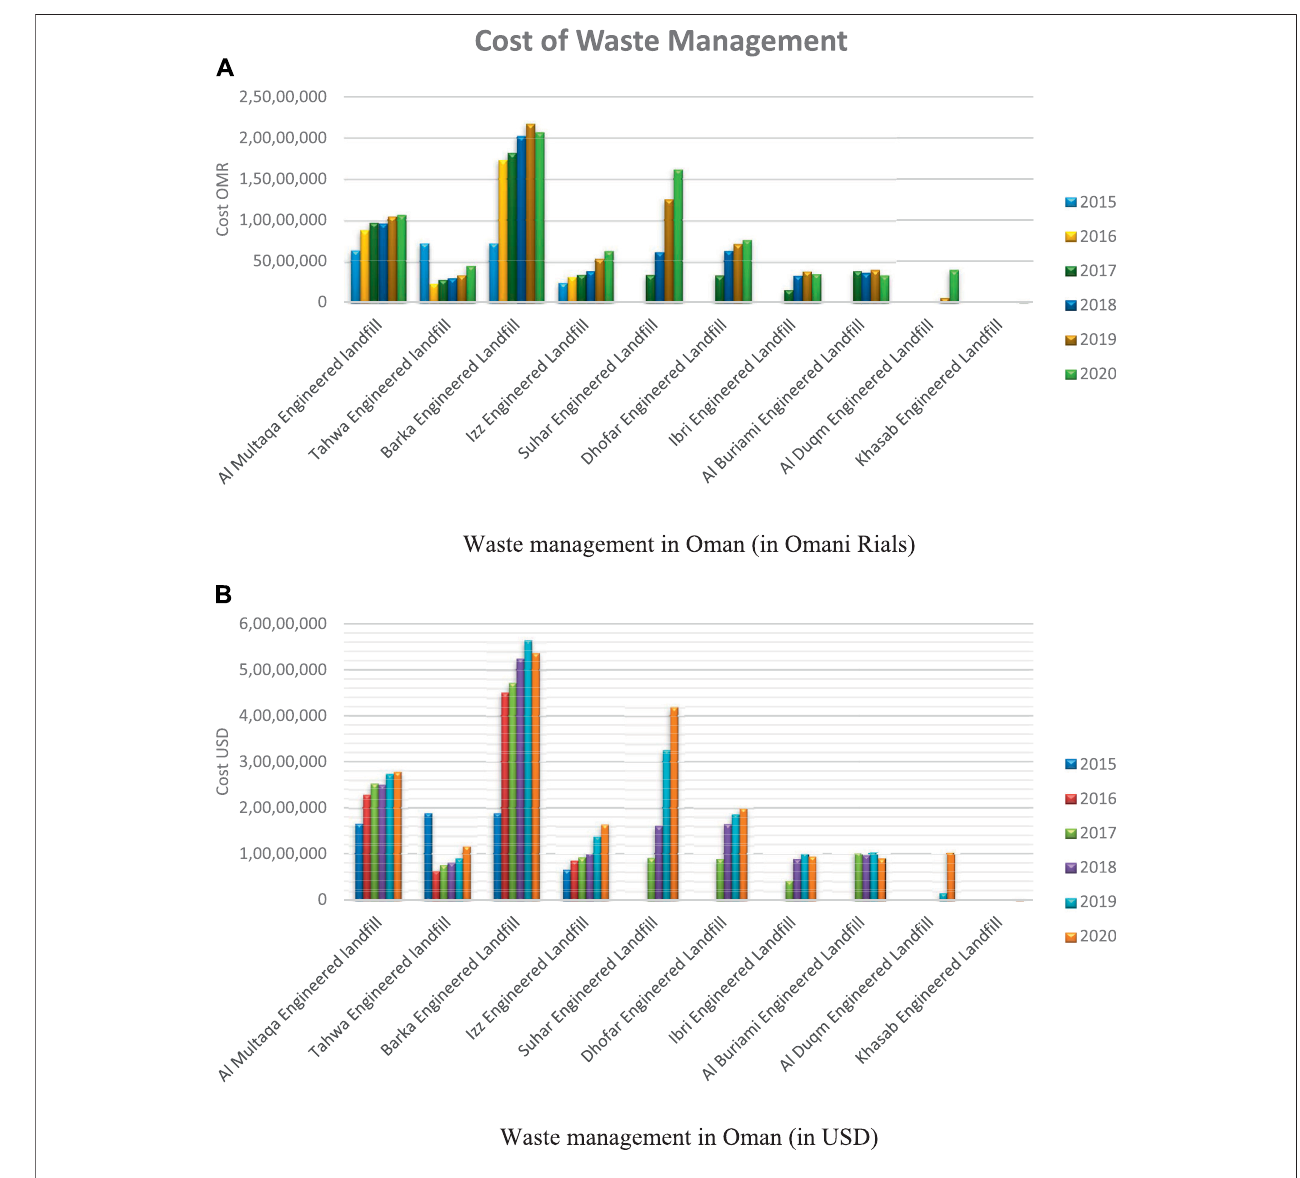
FIGURE 15 | Cost of waste management in Oman. (A) Waste management in Oman (in Omani rials) and (B) waste management in Oman (in USD).